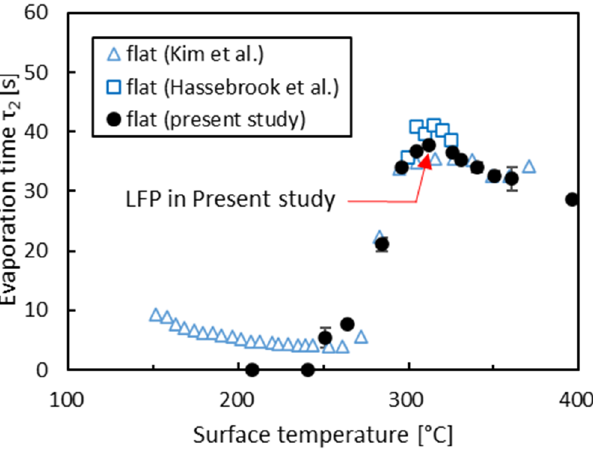
Figure 4. Comparison of evaporation time with those in previous studies [16,27].